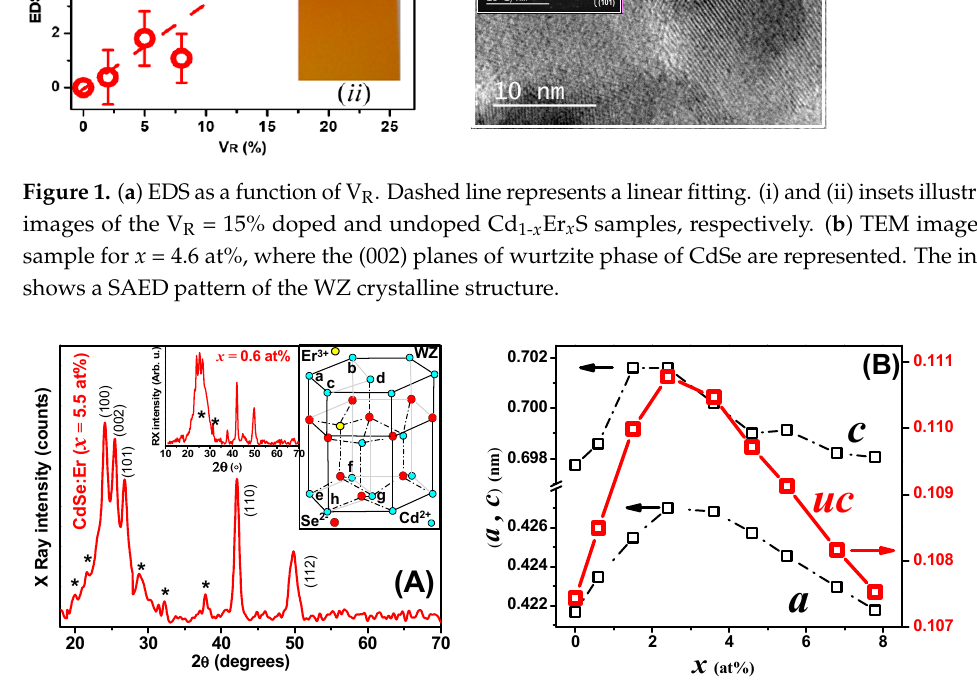
Figure 2. ( A ) XRD pattern of the CdSe:Er film for x = 5.5 at%. The left inset shows the pattern for x = 0.6 at%. The right inset illustrates the unit cell of WZ-CdSe lattice. ( B ) (left axis) lattice parameters a and c versus x , (right axis) primitive unit cell volume versus x .